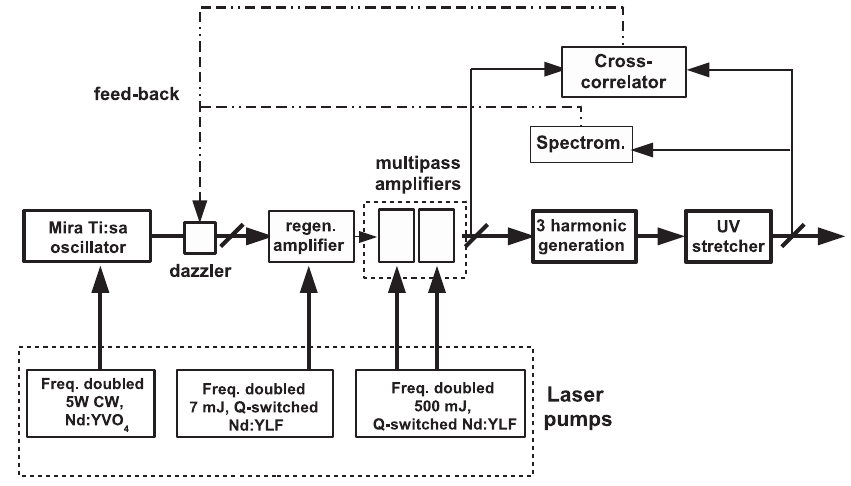
FIG. 3. Schematic layout of the laser